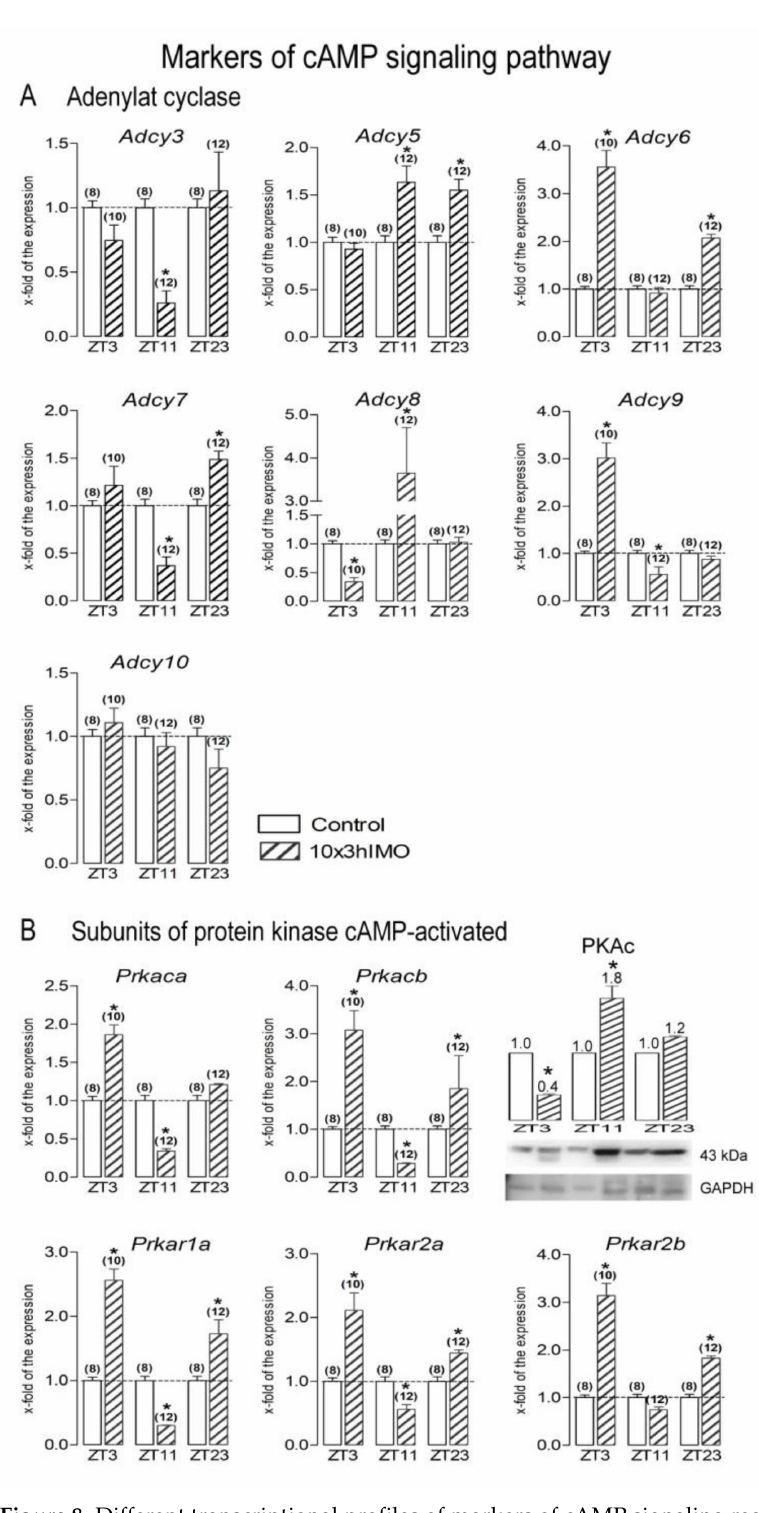
Figure 8. Different transcriptional profiles of markers of cAMP signaling regulating mitochondrial dynamics and functionality as well as spermatozoa number and functionality in spermatozoa of repeatedly stressed adult rats at different time points. Spermatozoa isolated from undisturbed and repeatedly stressed rats were used for RNA isolation and further analysis of the transcriptional profile of markers of cAMP signaling pathway. Data bars are mean ± SEM values of two independent in vivo experiments (n = number of rats). Statistical significance was set at level p < 0.05: * vs. control group of the same time